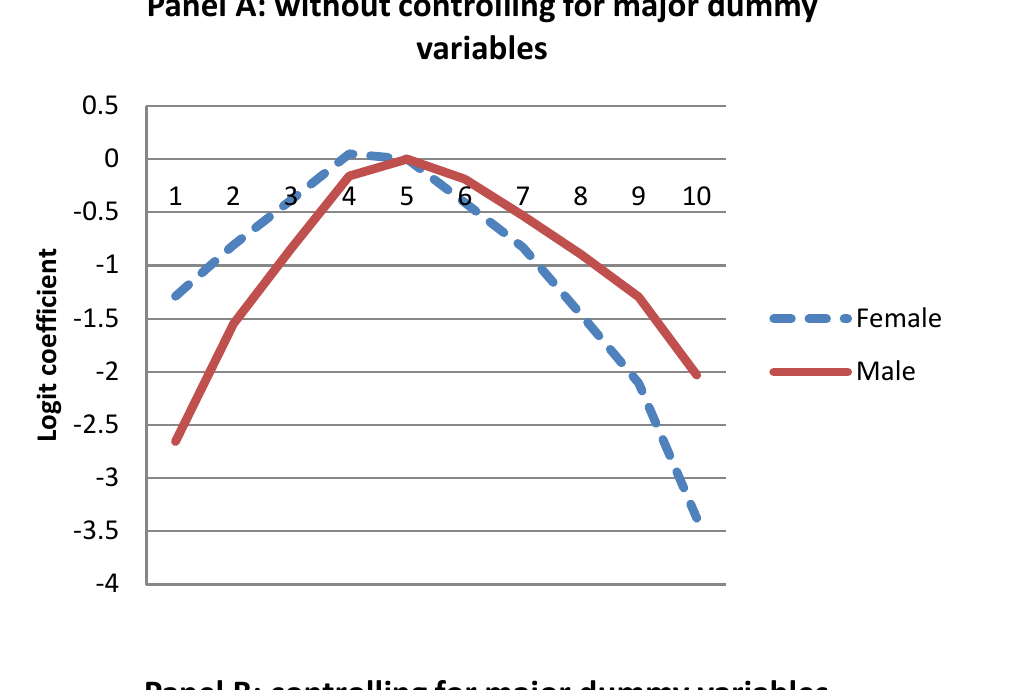
Figure 4. Unidimensional Preferences Model: Effects of Difficulty of Being Accepted on Choice, TECH Based on the results of Table 3.